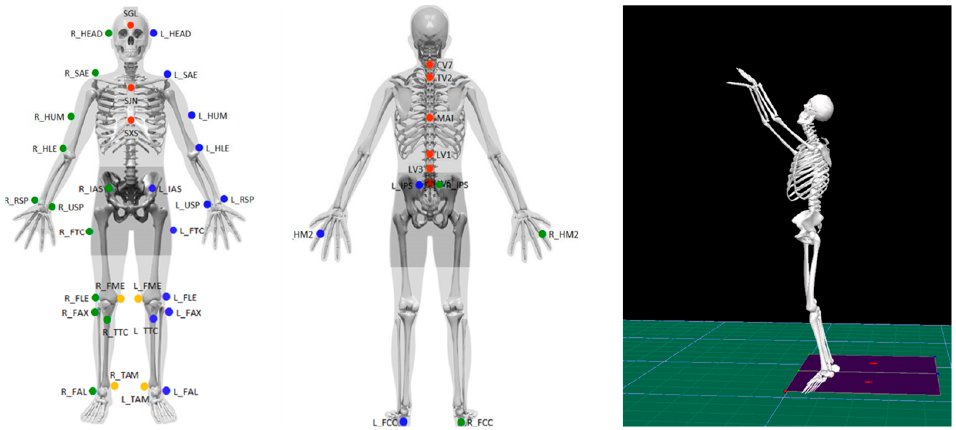
Figure 1. Markerset and visual 3D representation.